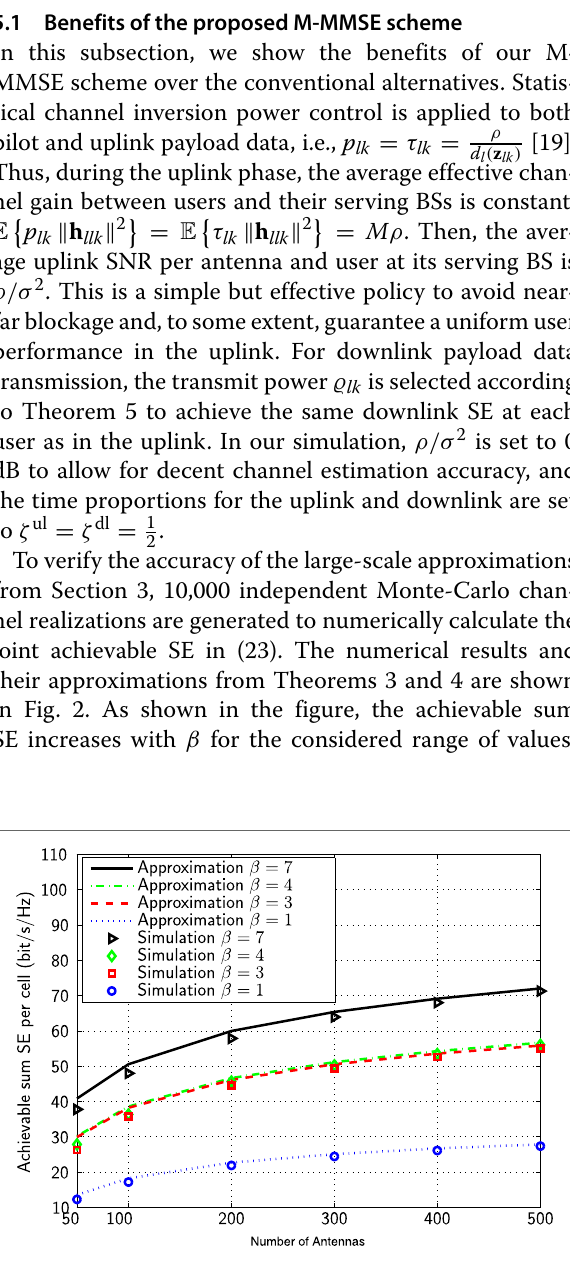
Fig. 2 Achievable sum SE as a function of the number of antennas M , for β ∈ { 1,3,4,7 } , K = 10 and c = 0.0001